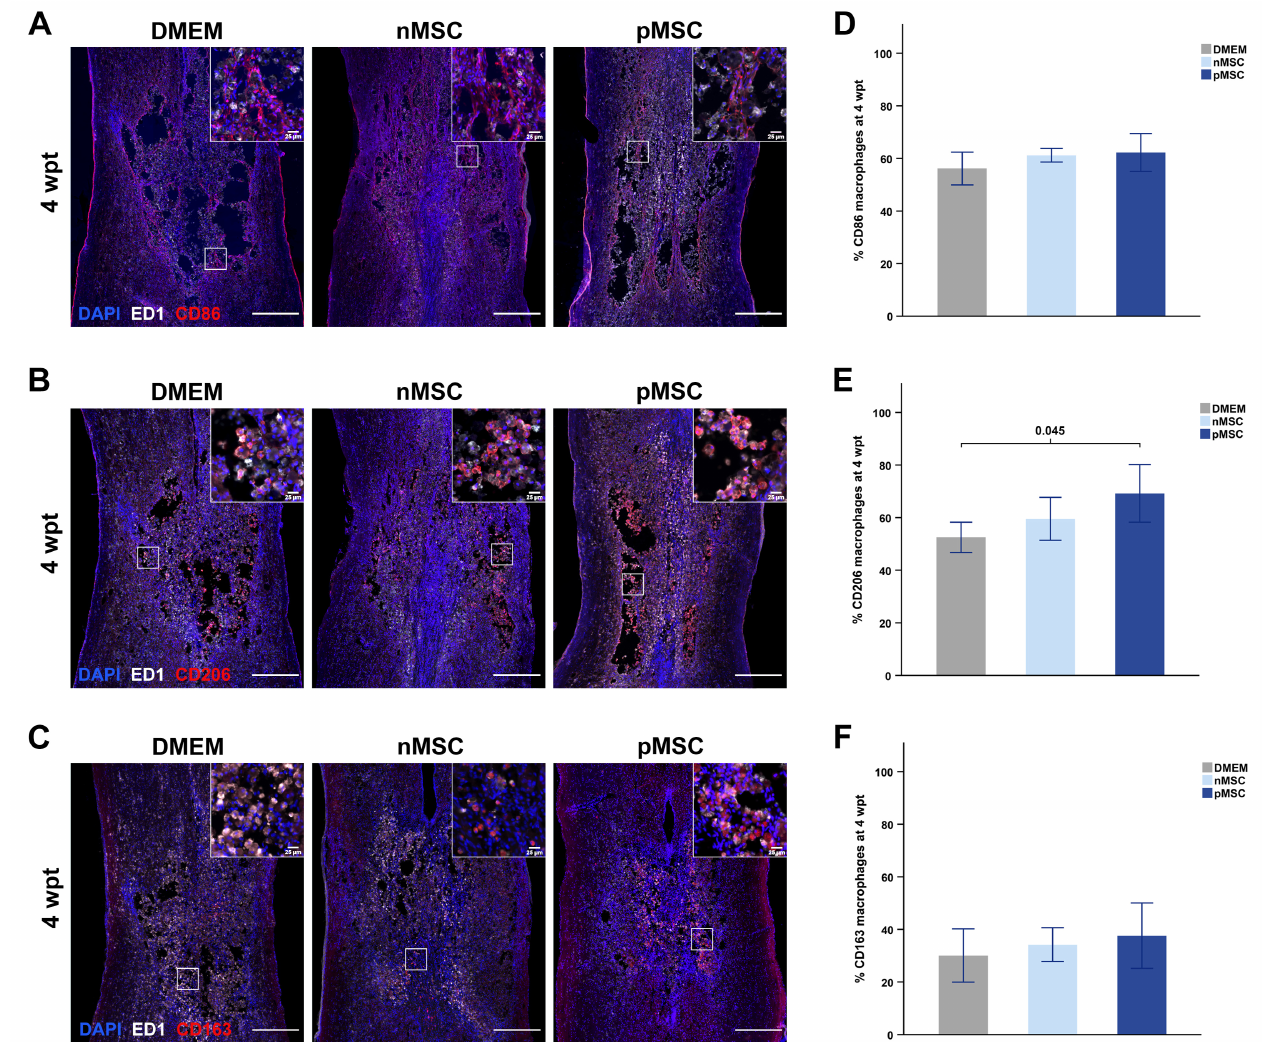
Figure 4. pMSC transplants induce transient immunomodulation at 4 wpt. ( A – C ) Example photomicrographs of injured spinal cords at 4 wpt. Inlets represent a close-up detail of the staining; a square on the overview designates the source for the inlet image. The spinal cords’ orientation is top–rostral and bottom–caudal. ( A ) Pro-inflammatory macrophages were quantified using CD86 (red), ED1 (white), and DAPI (blue) staining. ( B ) Early-acting pro-inflammatory macrophages were quantified using CD206 (red), ED1 (white), and DAPI (blue) staining. ( C ) Late-acting pro-inflammatory macrophages were quantified using CD163 (red), ED1 (white), and DAPI (blue) staining. For ( A – C ) , intensity was equally modified on all images for illustrative purposes only but not for quantitative analysis. Scale bars on all images represent 500 µ m for the overviews and 25 µ m for the inlets (Overviews: 4 × , image scan: 20 × , Inlets: 20 × ). ( D ) Bar graph representing the percentage of pro-inflammatory macrophages, relative to the total number of macrophages in the injury at 4 wpt. No significant differences were found between groups. ( E ) Bar graph representing the percentage of early anti-inflammatory macrophages, relative to the total number of macrophages in the injury at 4 wpt. pMSC transplants result in 20% more CD206-positive macrophages compared to controls. ( F ) Bar graph representing the percentage of late anti-inflammatory macrophages, relative to the total number of macrophages in the injury at 4 wpt. No significant differences were found between groups. On ( D – F ), bars represent the mean and SEM, and significance was accepted at p < 0.05. n = 6 per group and time point. Abbreviations: DMEM: Dubbelco’s Modified Eagle’s Medium; nMSC: naïve MSC; pMSC: primed MSC; wpt: weeks post-transplant; MSC: mesenchymal stromal